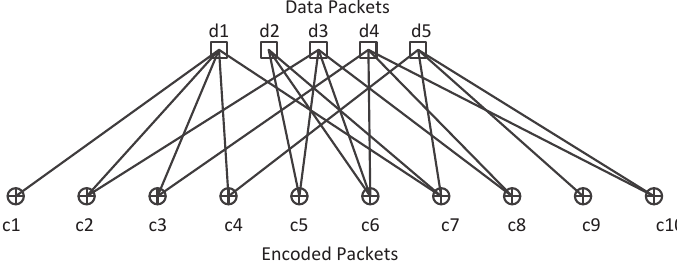
Figure 2. A typical encoding process of LT